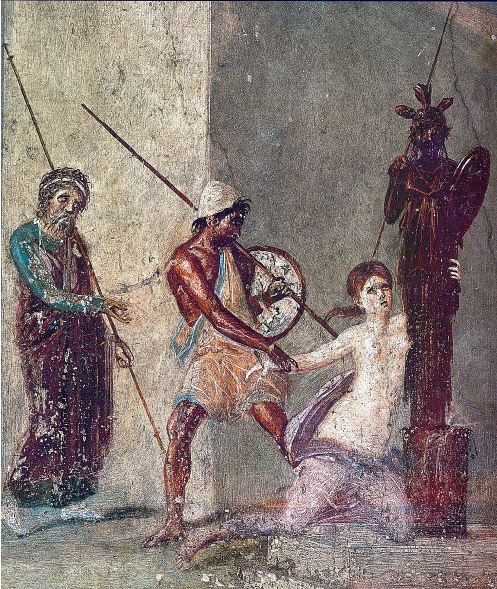
Figure 5. Cassandra abducted by Ajax the lesser with her father, Priam. Section of a wall painting, 1st century CE, from the House of Menander (I, 10, 4), Pompeii, Italy. Image Source: Ranieri Panetta (2005, p. 349). (Public Domain. Image File Link: https://commons.wikimedia.org/wiki/File: Pompeii_-_Casa_del_Menandro_-_Menelaos.jpg accessed date: 2 January